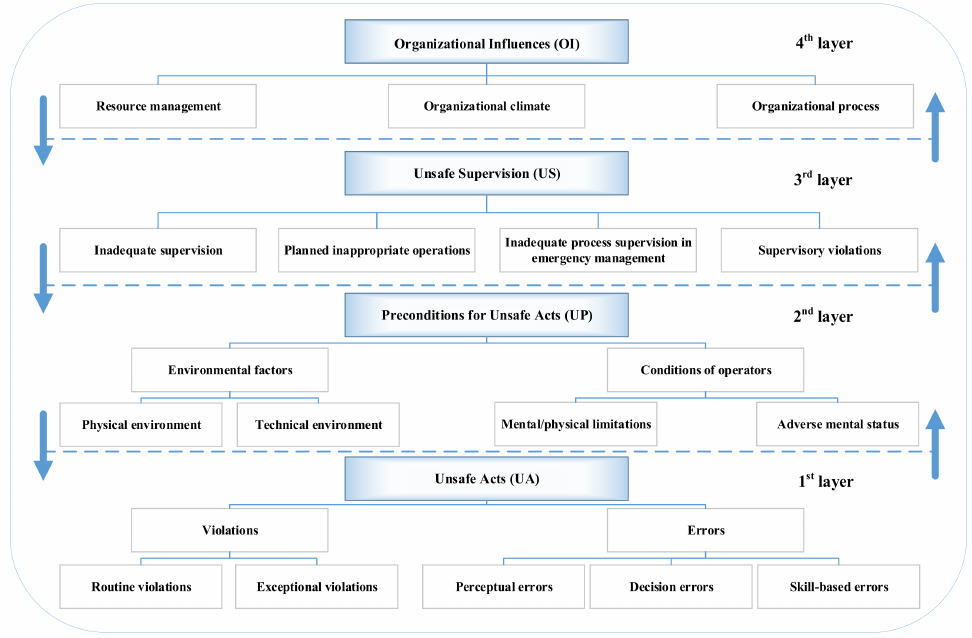
Figure 4. The hierarchy and categories involved in the modified